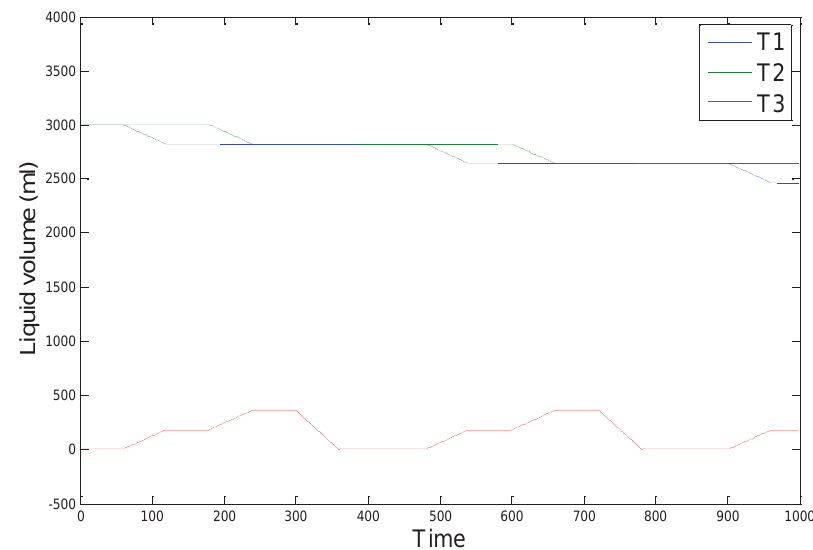
Figure 7. The values of sensors with the change of time under the normal